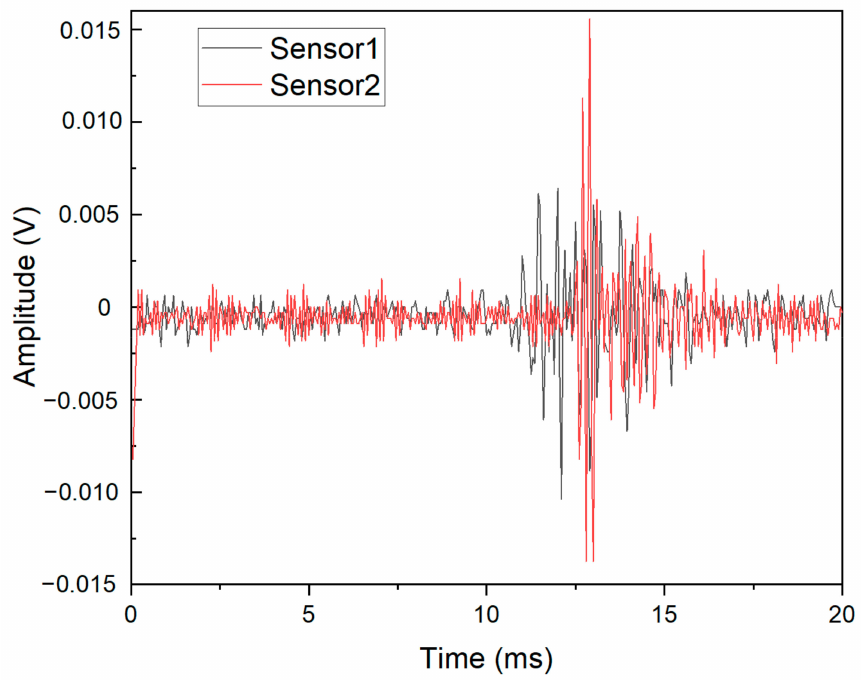
Figure 2. Raw AE signals (time domain) of fiber